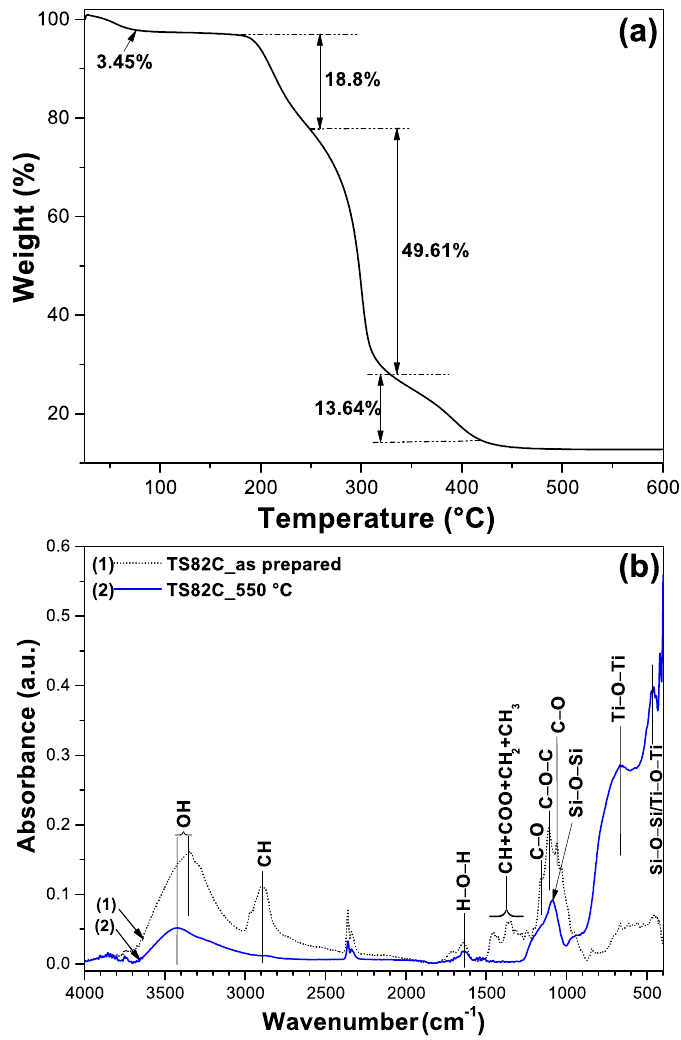
Figure 1. ( a ) Thermogravimetric analyses (TGA) of as prepared TS82C. ( b ) FTIR spectra of as prepared (curve 1) and 550 °C annealed (curve 2) TS82C.